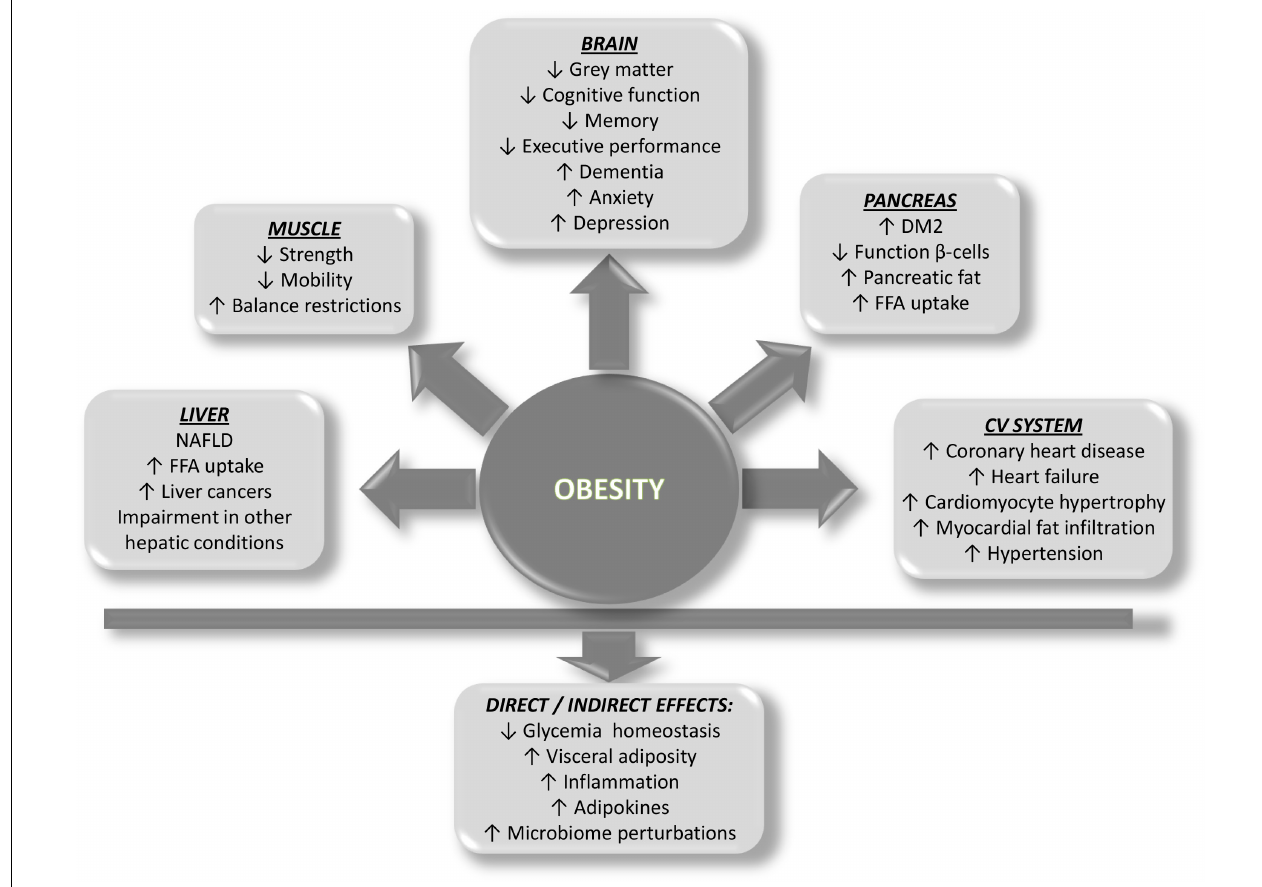
FIGURE 2 | Scheme showing the predicted impact of obesity on organ systems and the direct and indirect effects on